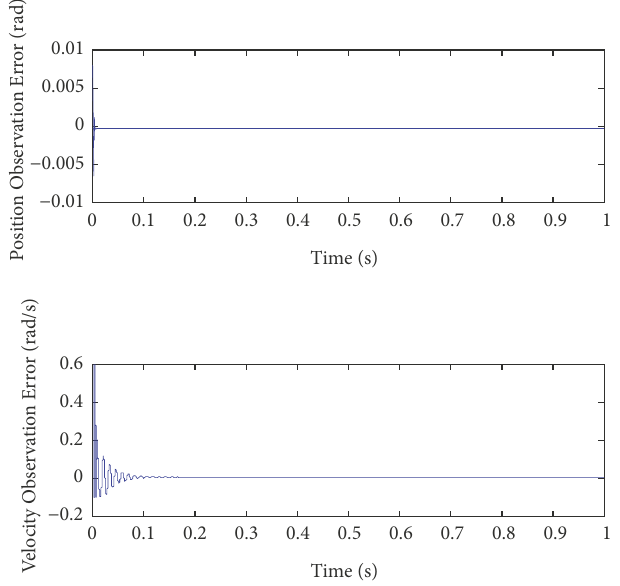
Figure 8: The estimation error of position and velocity of link2.